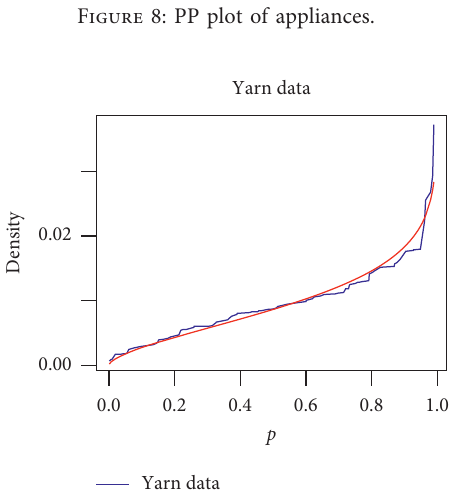
Figure 8: PP plot of appliances.